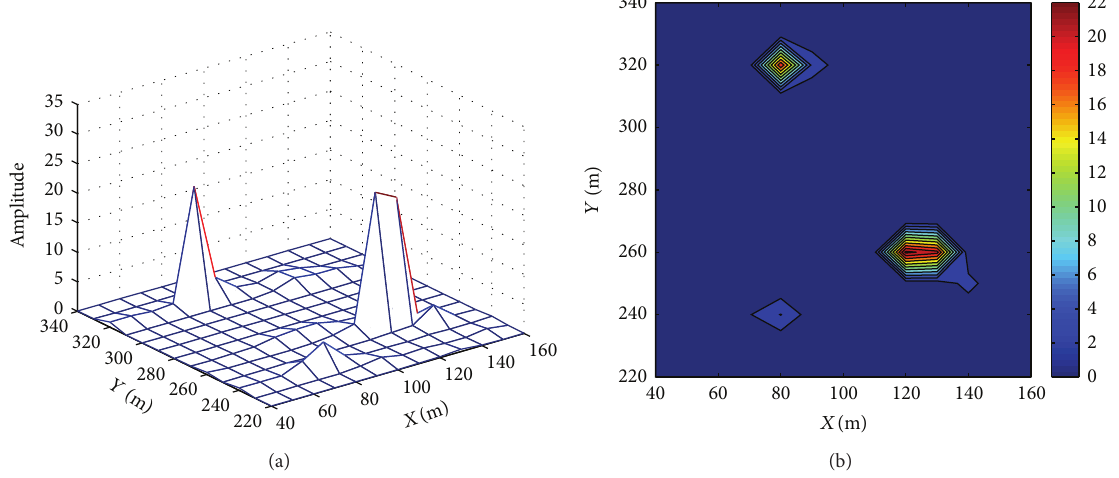
Figure 10: Off-grid reconstructed target reflection coefficients using BSBL- ℓ 1 method. SNR = 10dB. (a) 3-D plot, (b) 2-D contour